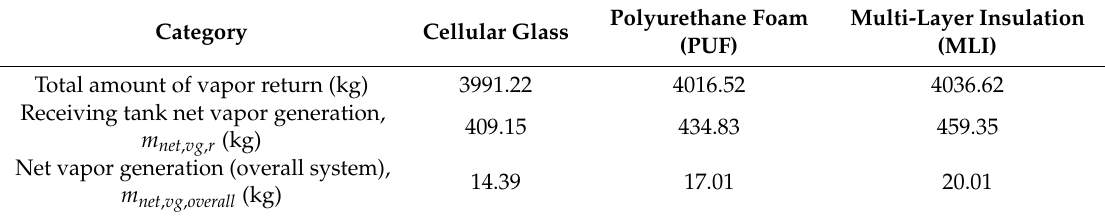
Table 7. Total amount of vapor return and net vapor generation with di ff erent insulation